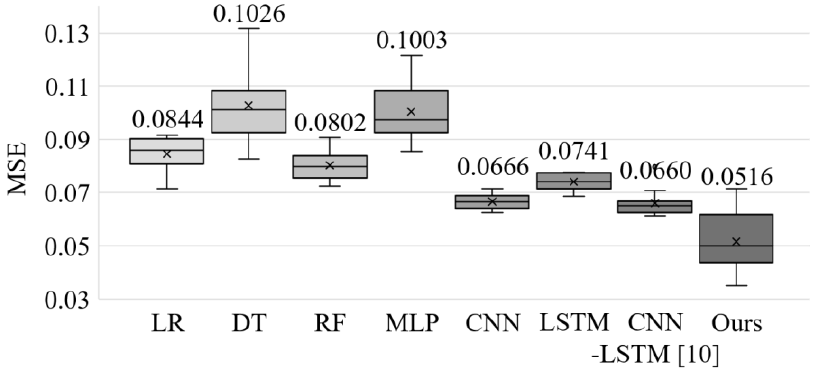
Figure 6. 10-fold cross validation of the methods including the deep learning models. Table 4. Comparison of MSE according to time resolution and modeling method (LR: linear